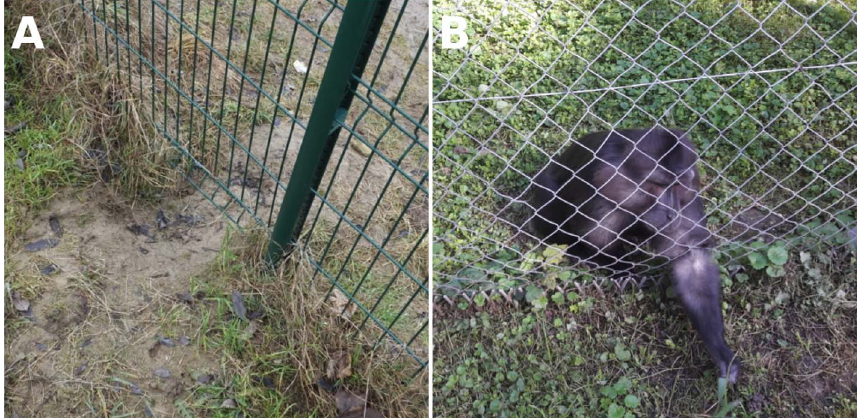
Figure 2. Two types of interaction between non-human primates and local wildlife. (A) Foxes ( Vulpes vulpes ) are able to dig passages under the fences of cages, and (B) non-human primates commonly look for food outside the fence, like this Tonkean macaque ( Macaca tonkeana